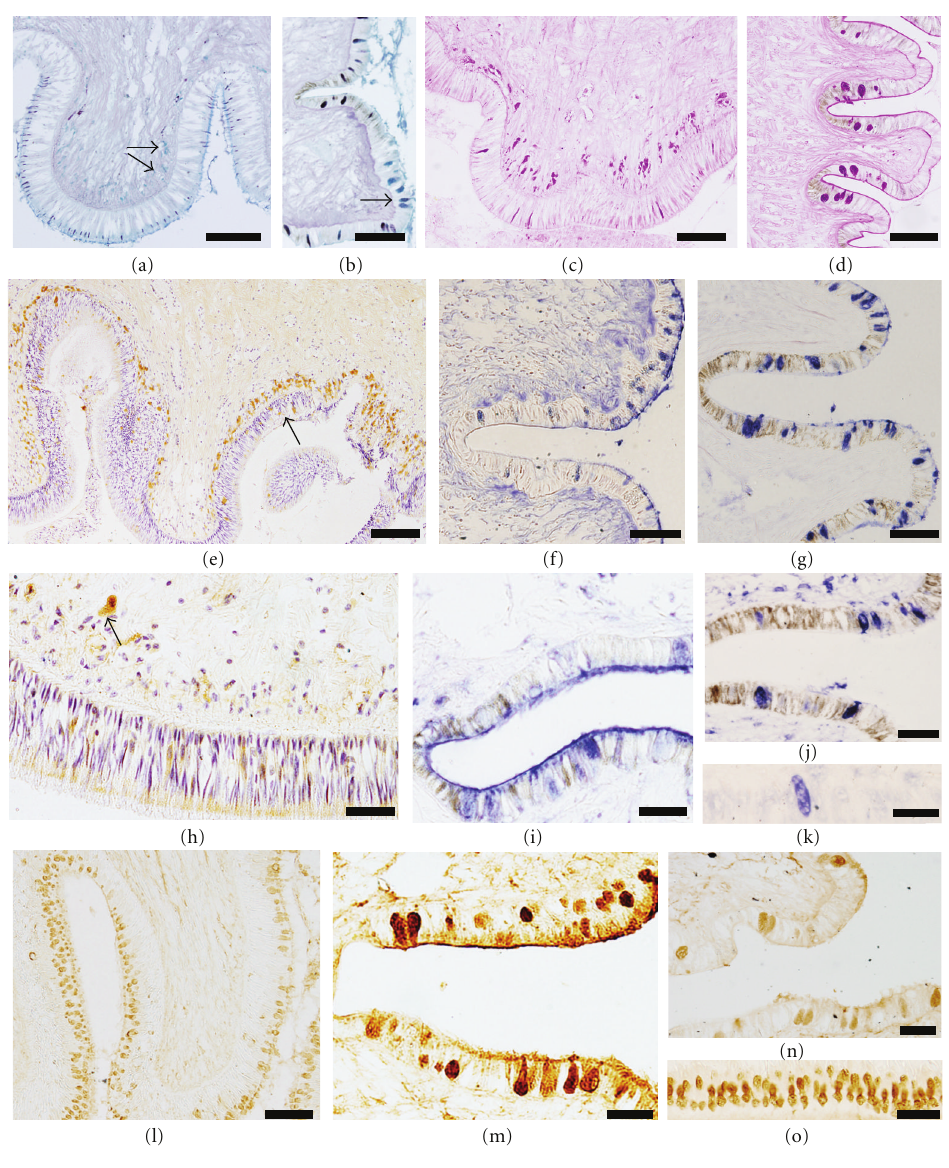
Figure 3: Histochemistry of the sole and side foot (sections are oriented to the bottom for the sole foot and to the right for the side foot, according their natural location) of Haliotis tuberculata . (a) and (b) HID/AB. The sole (a) and side (b) secretory cells in dark containing sulphated acidic glycoconjugates, moreover some subepithelial glands (a, arrows) and side secretory cells (b) stain in blue revealing the presence of carboxylated acidic glycoconjugates. Both glycoconjugates are present in a few secretory cells (b, arrow). Bar: 200 µ m (a), 100 µ m (b) (c) and (d). PAS. Presence of neutral glycoconjugates in the sole secretory cells and subepithelial gland (c), and the side secretory cells (d) Bar: 200 µ m (c), 100 µ m (d) (e) UEA I (fucose). The subepithelial glands are strongly reactive to the lectin, and a few secretory cells (arrow) are also positive. Biotinylated lectin, counterstained with hematoxylin. Bar: 100 µ m. (f) and (g) AAA (fucose). Some side secretory cells show positivity (f) which increases after desulphation (g) Lectin labeled with digoxigenin. Bar: 100 µ m. H. Con A (mannose). The apical portion of the sole epithelial cells and subepithelial gland exhibit reactivity to mannose. Biotinylated lectin, counterstained with hematoxylin. Bar: 50 µ m. (i) GNA (mannose). After desulphation GNA binds to some side secretory cells. Lectin labeled with digoxigenin. Bar: 50 µ m. (j), and (k) PNA (Galactose beta 1-3 N-acetyl-galactosamine). After desulphation the number of side secretory cells increases (j) and a few sole secretory cells appear (k) Lectin labeled with digoxigenin. Bar: 50 µ m. (l) and (m) WGA (N-acetyl-glucosamine). The weak reaction changes after desulphation, increasing intensity and number of sole (l) and side (m) secretory cells. Subepithelial glands appear weakly stained (l). Biotinylated lectin. Bar: 100 µ m (l), 50 µ m (m) (n), and (o) DBA (N-acetyl-galactosamine). The number of positive side secretory cells increases after desulphation (n) and a high number sole secretory cells appear (o) Bar: 50 µ